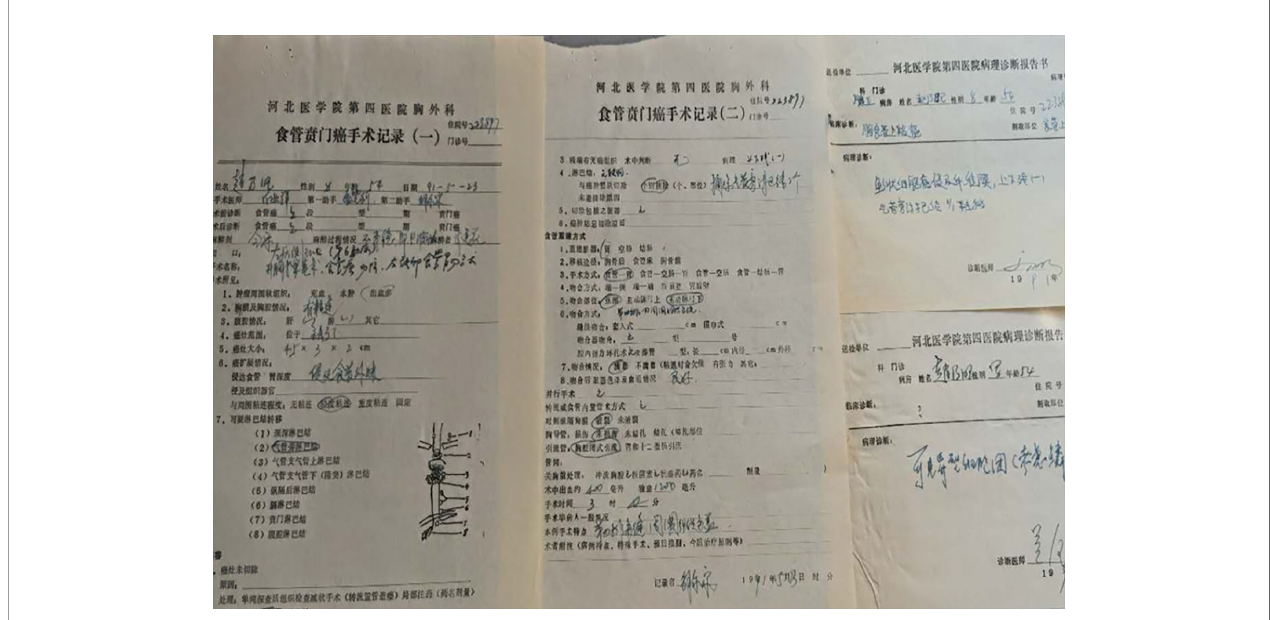
FIGURE 1 | Tumor, nodal, metastasis, and pathological data recorded in the medical chart of patients with esophageal or gastric cardia carcinoma at the Department of Thoracic Surgery in the Fourth Hospital of Hebei Medical University since